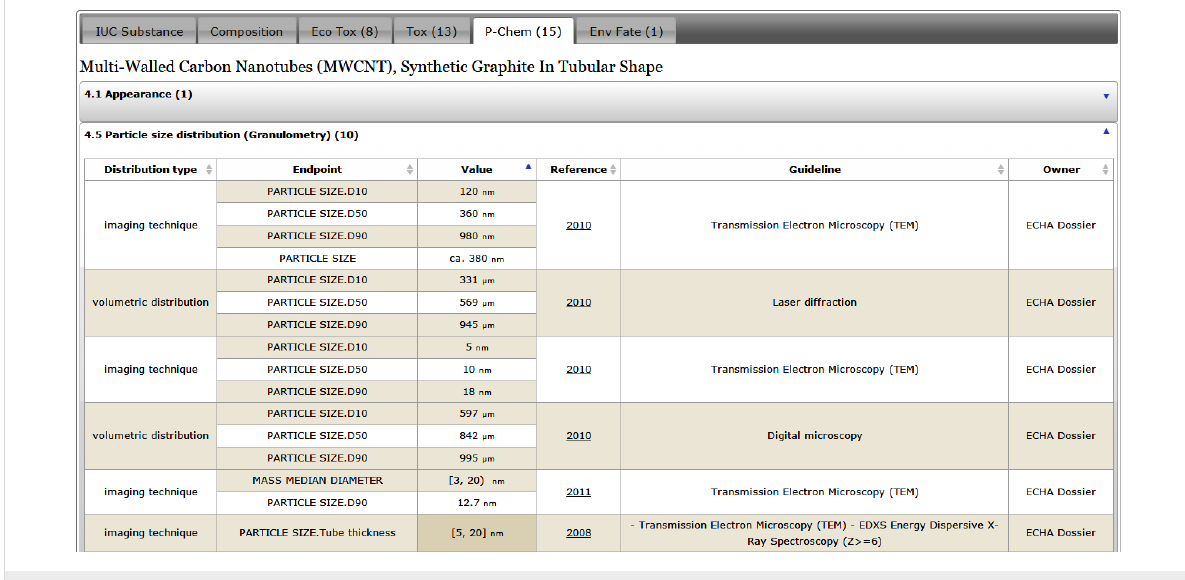
Figure 11: Physicochemical data for multi-walled carbon nanotubes. The screenshot illustrates the data model and UI support for size distribution (through percentiles D10, D50, D90), multiple endpoints per measurement (Mass median diameter and particle size), and multiple experiments using different